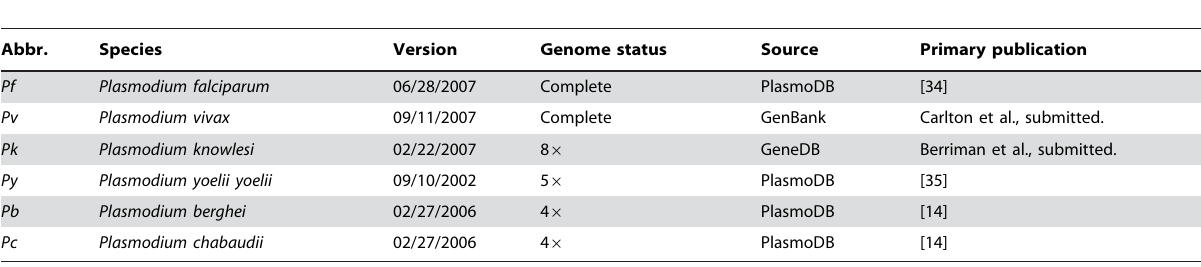
Table 1. Plasmodium genomes utilized in this paper, their status and sources.